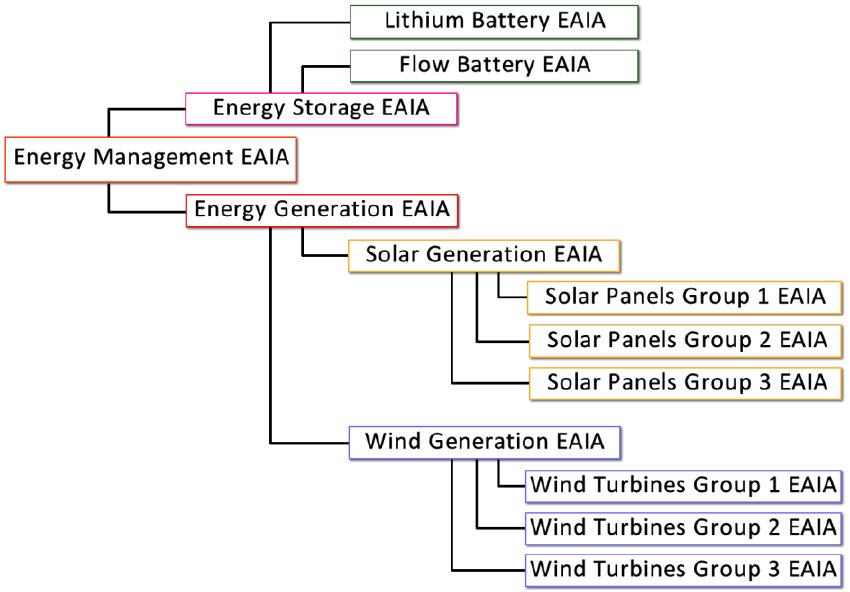
Figure 9. EAIA cooperation example.